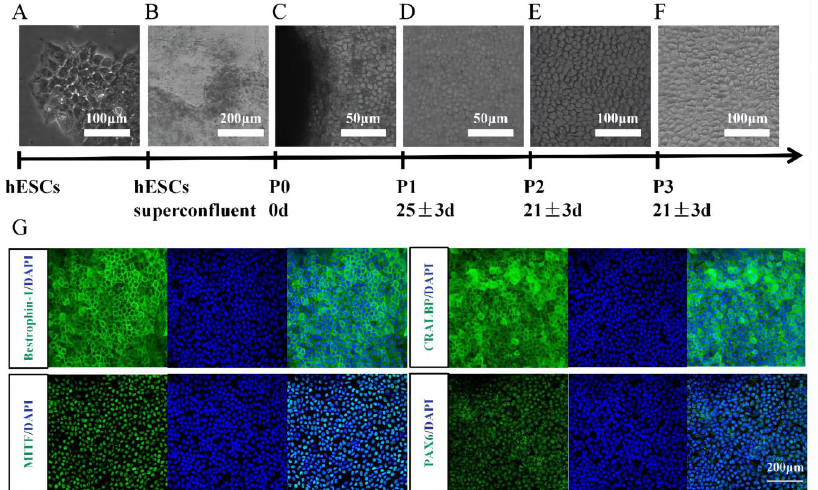
(Figure 1D). Immunostaining for bestrophin-1, CRALBP, MITF, and PAX6 in hESC-RPE cells demonstrated high purity and good differentiation (Figure 1G).